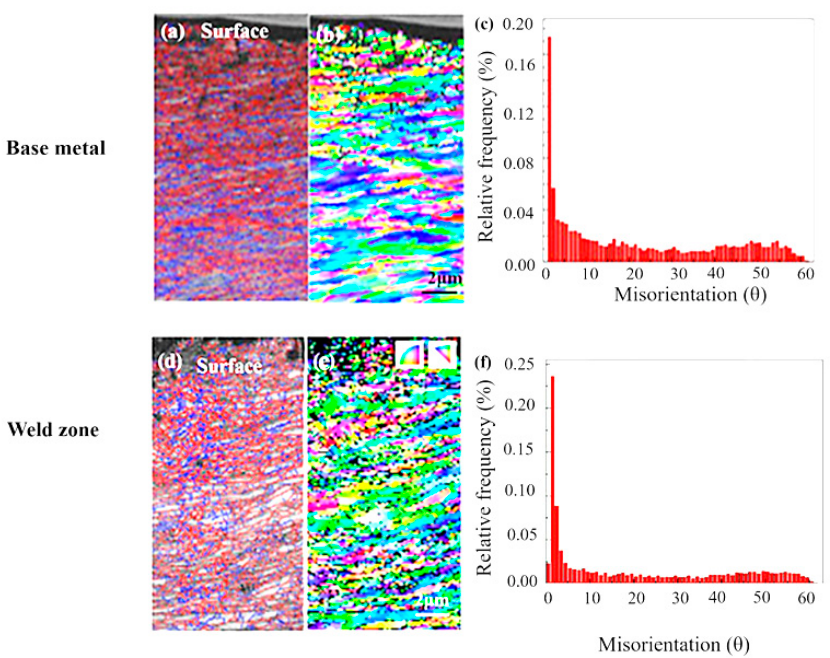
Figure 5. The EBSD micrographs of T4003 ferritic stainless steel welded joint after SURT. ( a – c ) Base metal. ( d – f ) Weld zone. Red lines: High angle grain boundary (HAGB), > 10 ◦ ; blue lines: low angle grain boundary (LAGB), 2–10 ◦.